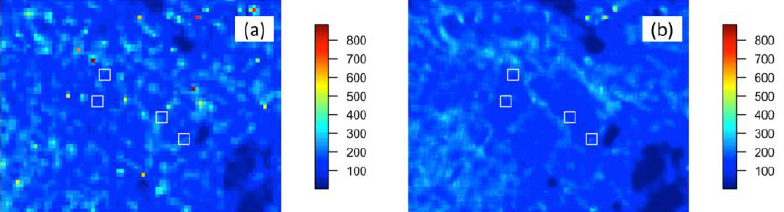
Figure 7. Zoomed-in estimated AGB in MAS forest. ( a ) AGB from the day 242 model. ( b ) AGB from seasonal mean model. The AGB from the seasonal mean shows less coherent speckles than that from the day 242 model. Note: the white rectangles are the study sites.